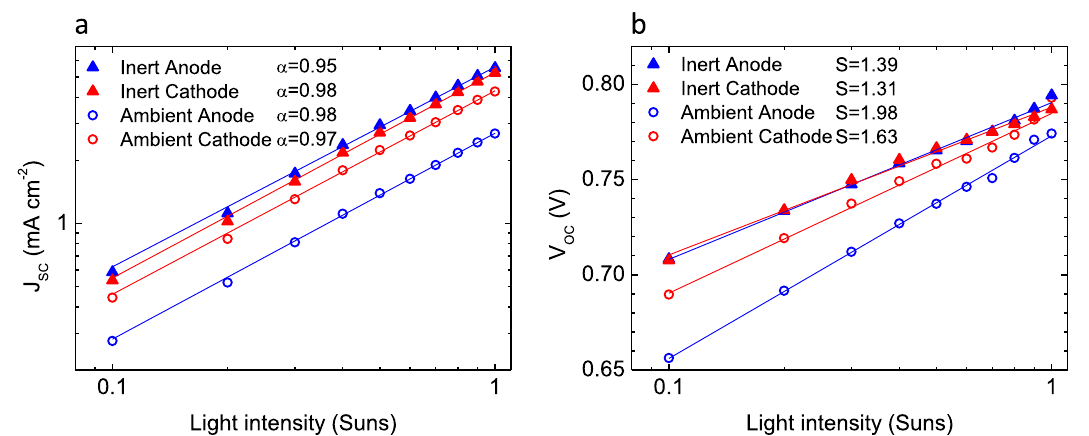
Fig. 6 Light intensity dependence a Short-circuit current and b open-circuit voltage as a function of light intensity for ambient (open circles) and inert devices ( fi lled triangles), for devices illuminated through the cathode (red) and through the anode (blue) side. Solid lines are fi ts to V OC = S*kT/q + m and J SC = I